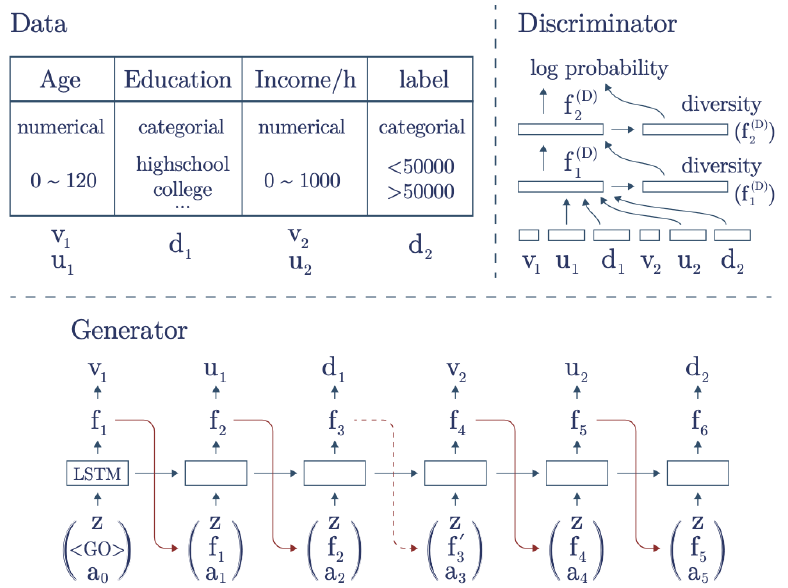
Figure 17. Diagram of a TGAN used in a toy example with 2 continuous and 2 discrete variables. Image taken from